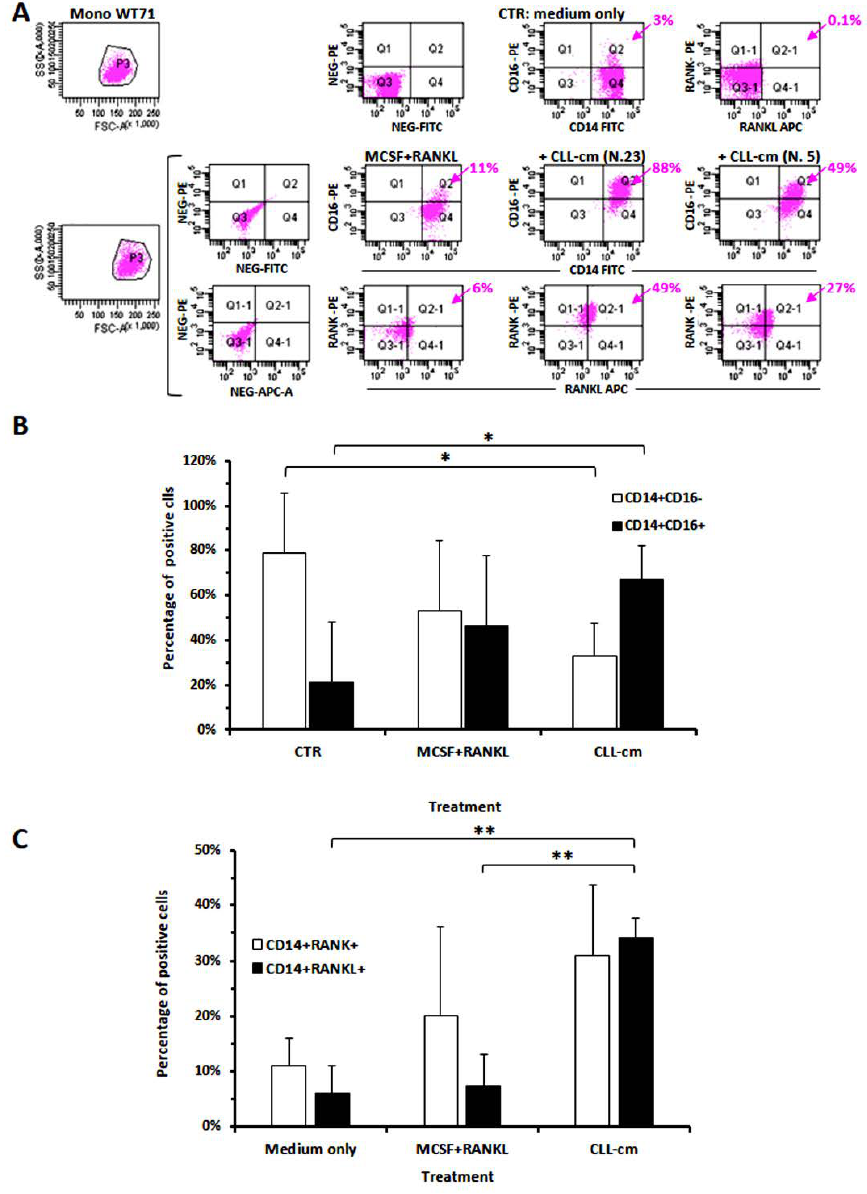
Figure 4. Modulation of CD16, RANK and RANKL expression in CD14+ healthy monocytes by CLL-cm treatment. ( A ) Presented dot plots show that CD16 expression was markedly induced when healthy monocytes (WT71) were cultured with CLL-cm (from two representative cases) for 48 h. ( B ) CD16 is significantly increased in purified monocytes treated with CLL-cm derived from B-cell cul- tures of 7 CLL patients. Histograms represent the means of 3 experiments ±SD using purified mon- ocytes from 3 healthy donors. ( C ) The addition of CLL-cm also increased the percentage of CD14+ monocytes expressing RANK and RANKL, as evaluated in purified monocytes derived from 3 healthy donors cultured with CLL-cm (n = 6) for 48 h. Histograms are mean ± SD of three experi- ments. Statistical significance was determined by using ANOVA and Tukey’s post hoc test.